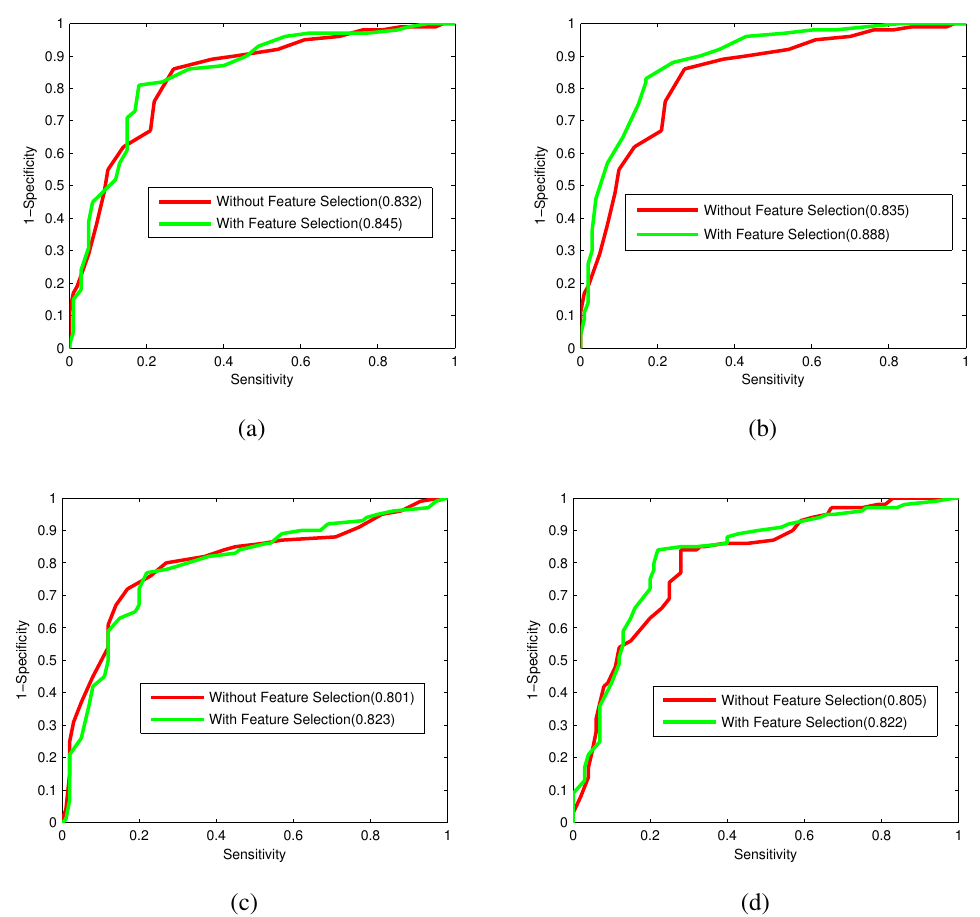
Figure 5. ROC curves for CTD, bi-profile Bayes, PseAAC and PSSM with and without feature selection. ( a ) ROC curves of the CTD model with and without feature selection; ( b ) ROC curves of the bi-profile Bayes model with and without feature selection; ( c ) ROC curves of the PseAAC model with and without feature selection; ( d ) ROC curves of the PSSM model with and without feature